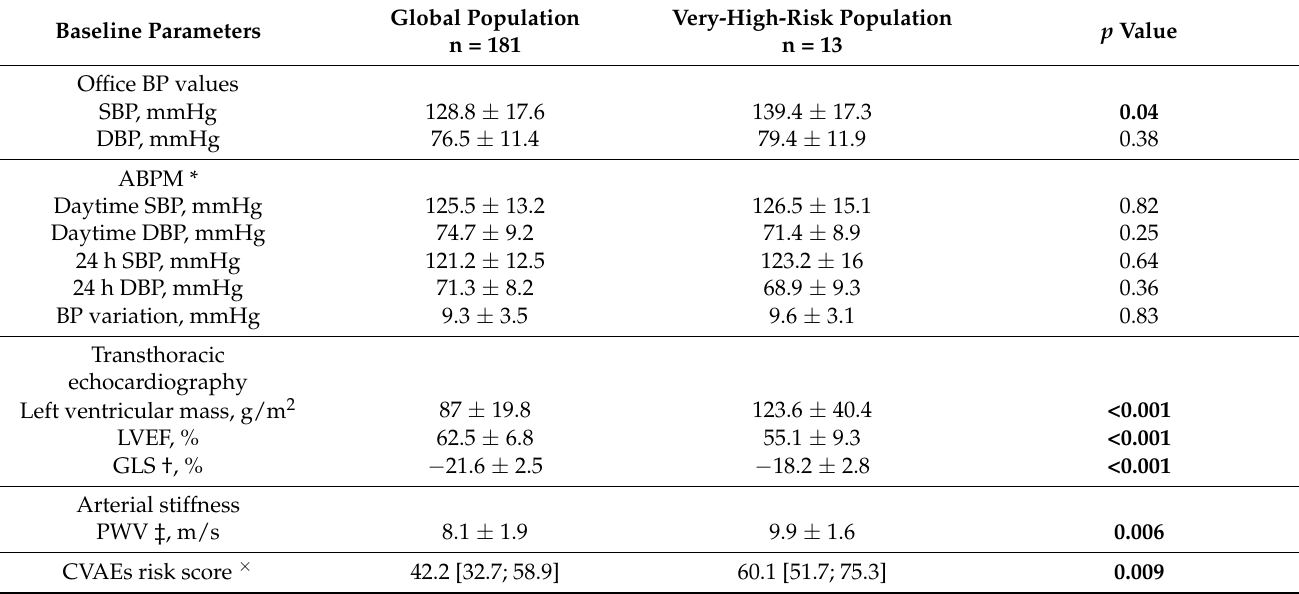
Table 2. Baseline hemodynamic and echocardiographic